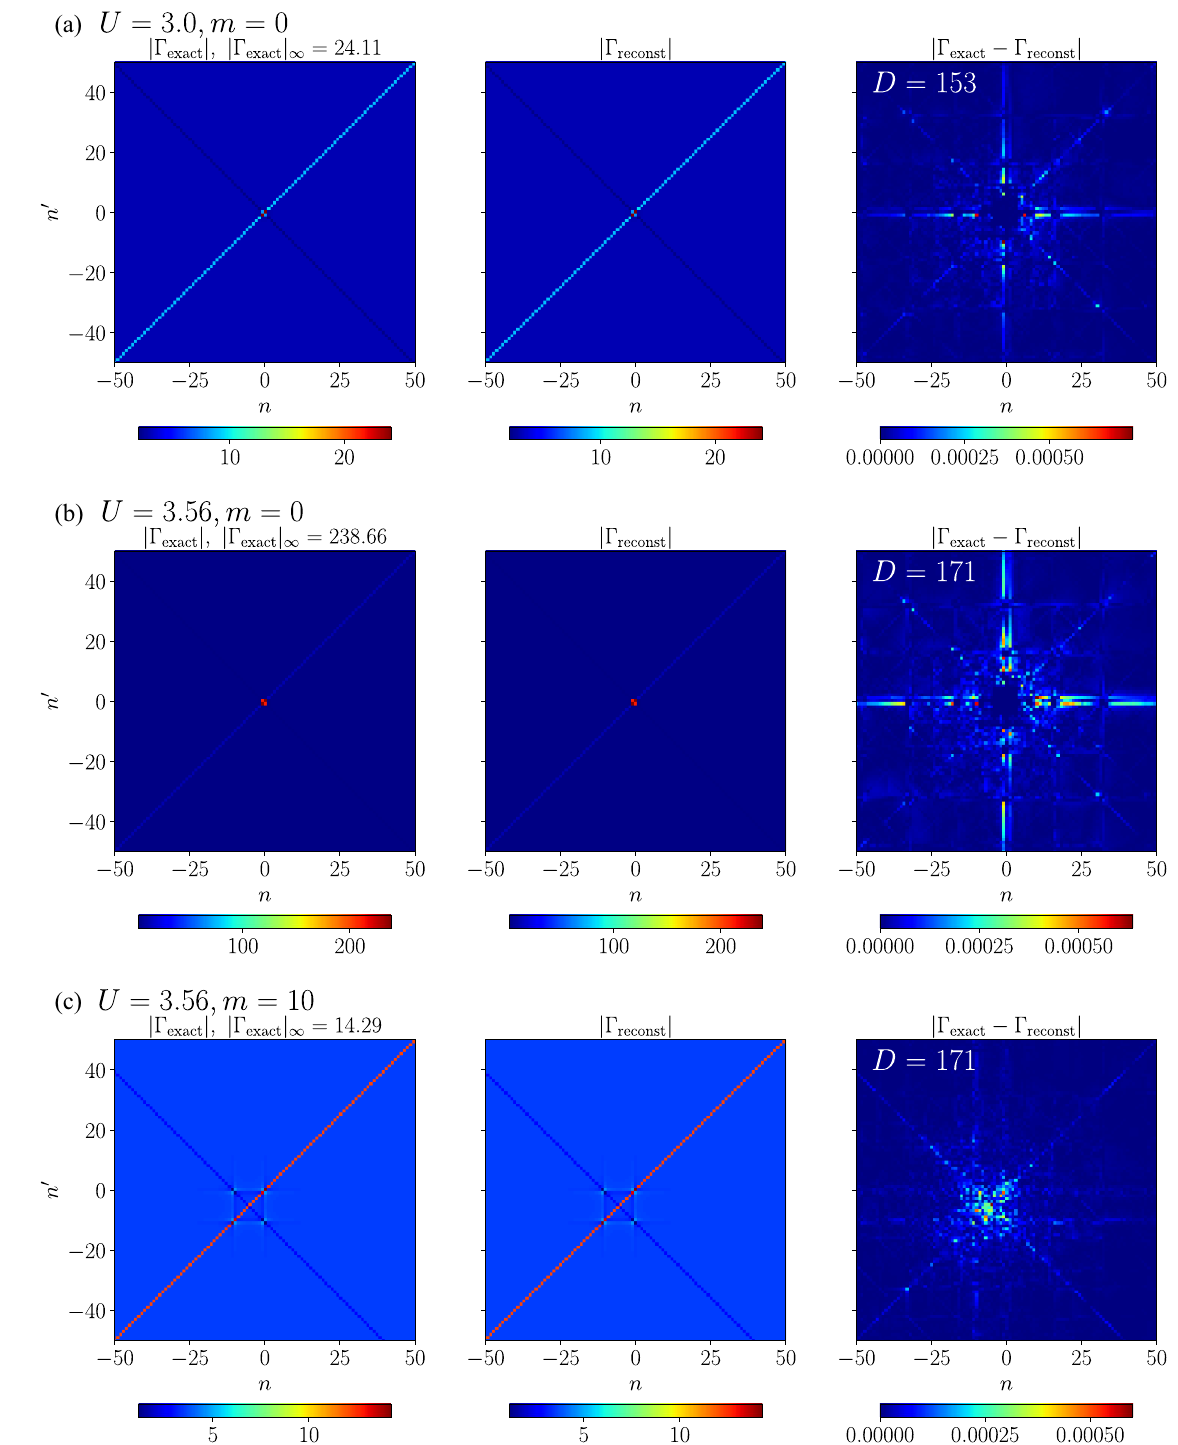
FIG. 14. Irreducible vertex function Γ of the Hubbard atom for two values of U : (a) U ¼ 3 . 0 and (b) – (c) U ¼ 3 . 56 and for a given d bosonic frequency 2 m π = β ( β ¼ 1 ). The middle panels show the reconstructed data from MPSs ( ϵ ¼ 10 − 14 ). The right panels show the error in the reconstructed data. Note that the entire three-frequency dependence is fitted by a single